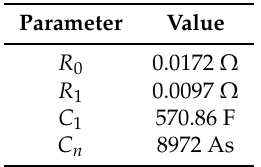
Table 1. Average values of equivalent parameters of the 1st-order Thevenin